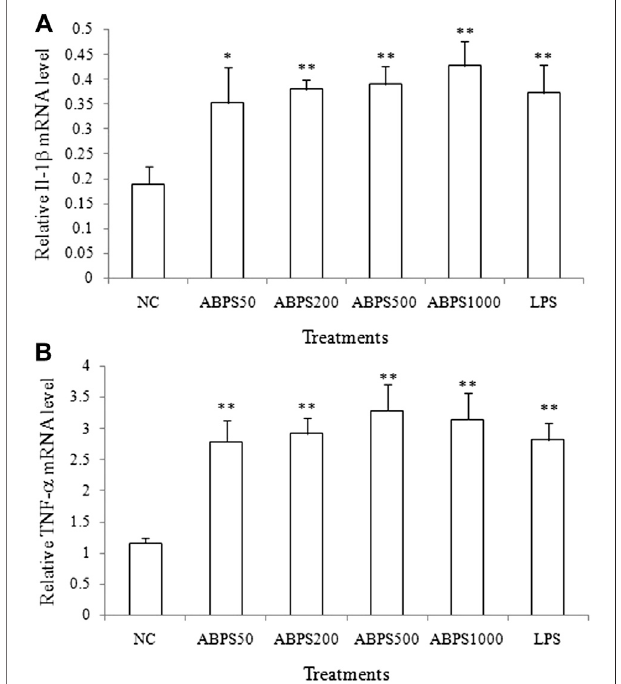
FIGURE 2 | Effects of ABPS on the mRNA expression of IL-1 β and TNF- α in J774 A.1 cells. The cells were treated with ABPS (0, 50, 200, 500, and 1,000 μ g/ml, respectively) or LPS (5 μ g/ml) for 24 h. Total RNA was isolated, and the mRNA expression levels of (A) IL-1 β and (B) TNF- α were determined. NC: normal control; ABPS50: 50 μ g/ml ABPS treated; ABPS200: 200 μ g/ml ABPS treated; ABPS500: 500 μ g/ml ABPS treated; ABPS1000: 1,000 μ g/ml ABPS treated; and LPS: 5 μ g/ml LPS treated (positive control). * p < 0.05, ** p < 0.01, vs. NC. The values are presented as means ±